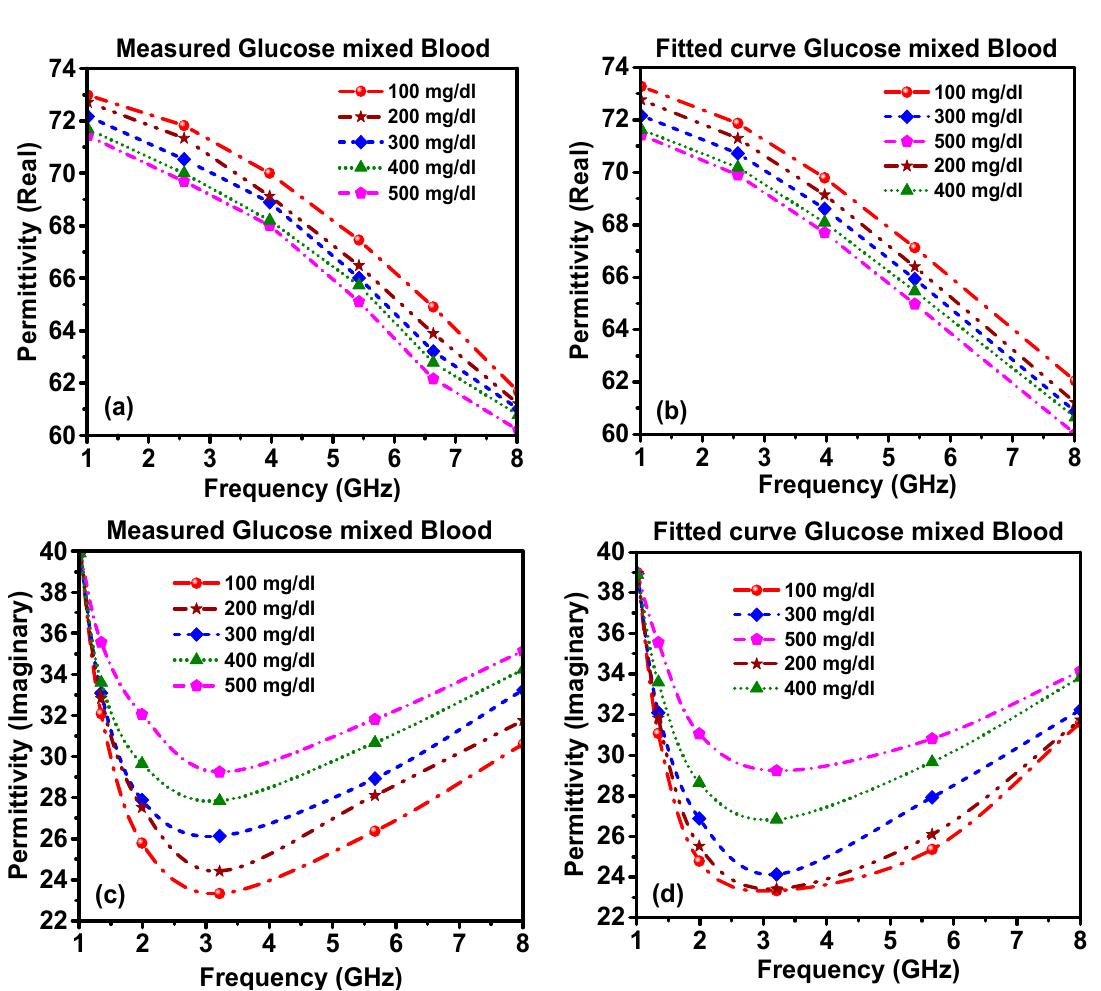
Figure 5. The complex permittivity of glucose–blood mixture: ( a ) measured real part, ( b ) calculated real part, ( c ) measured imaginary part and ( d ) calculated imaginary part.